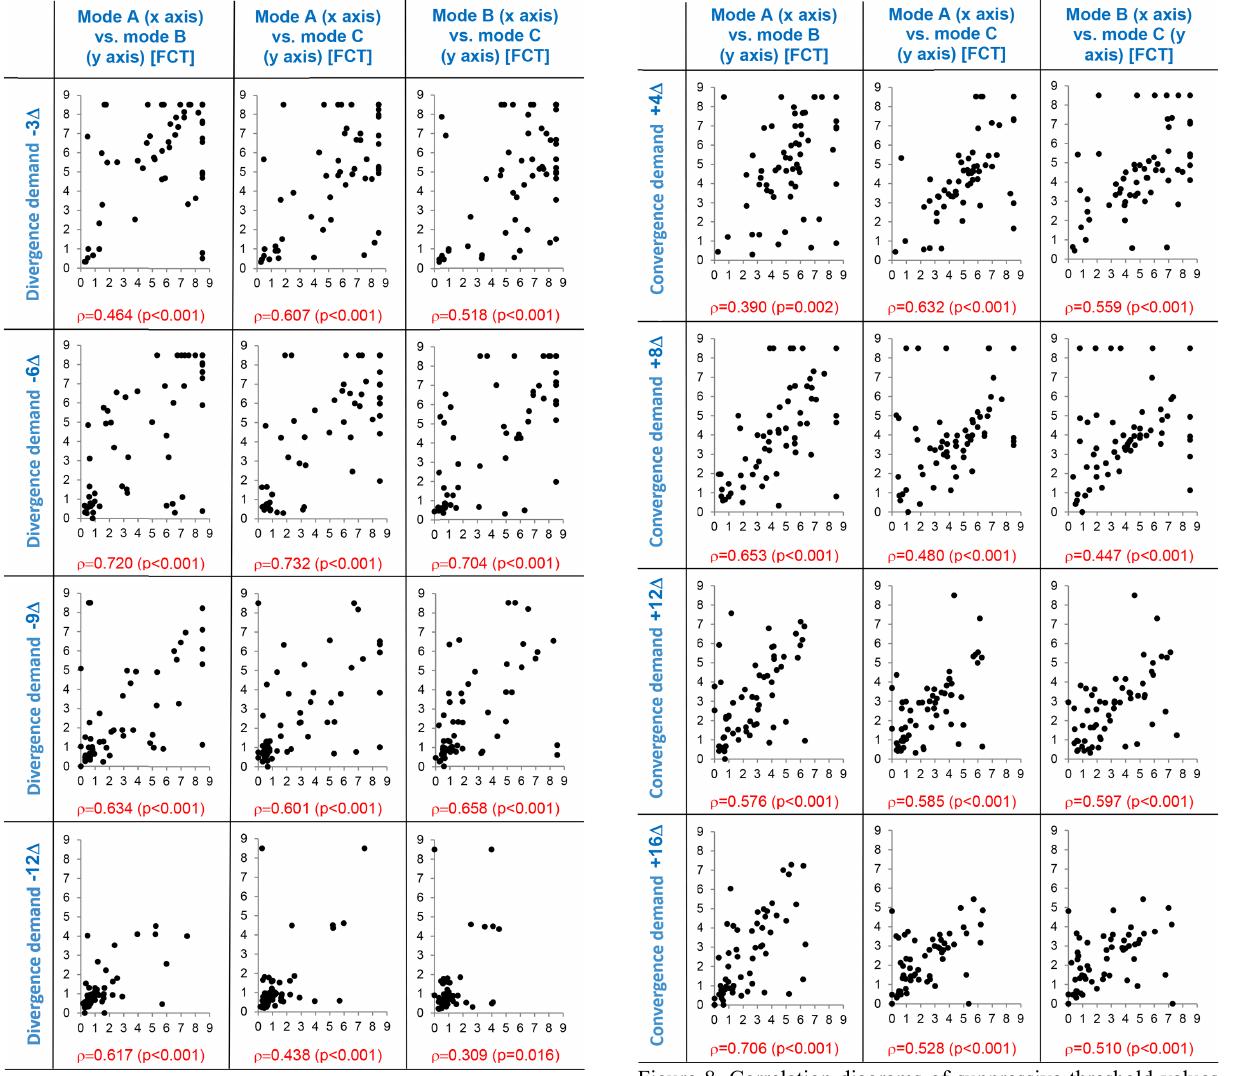
Figure 7. Correlation diagrams of suppressive threshold values between experimental degradation modes A, B, and C during divergence demand.